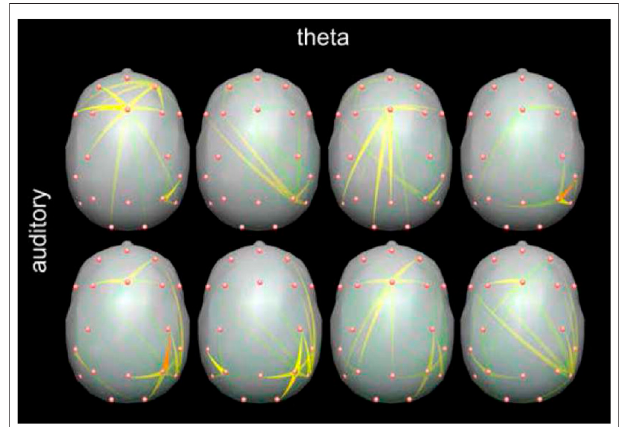
FIGURE 2 | Snapshots from animation showing propagation in the teta frequency band during working memory task obtained by time-varying DTF (SDTF). The time lapse between the pictures is 0.75 s. The color scale shows fl ow intensity (red is the strongest). The engagement of the frontal and posterior/temporal regions can be observed. Long-range transmissions from frontaltoposteriorlocationsandvice-versaoccurintermittently.Adaptedfrom Kaminski et al.,